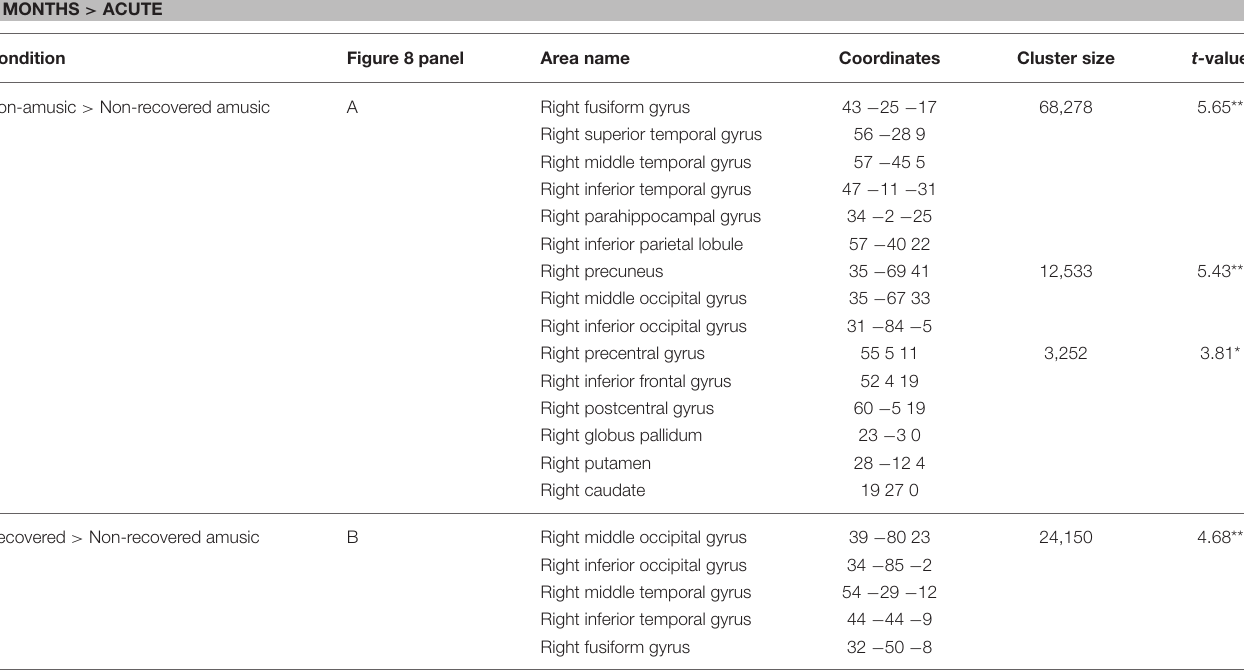
TABLE 7 | White matter volume decreases (6-month stage—acute stage) in rhythm amusia: pooled